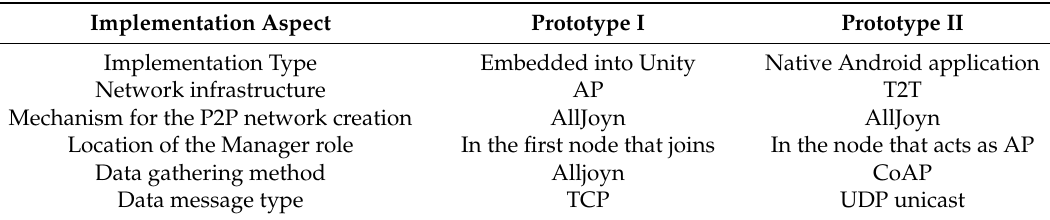
Table 5. Implementation details of the two